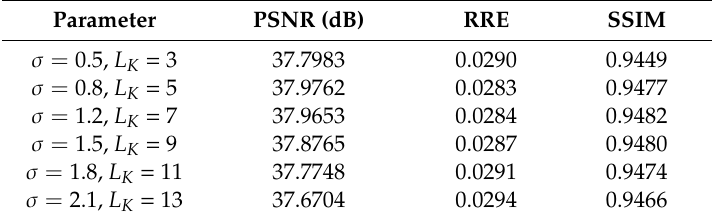
Figure 8. Thorax images reconstructed by the SIR-STV 1 method with respect to different 𝜎 and 𝐿 𝐾 . The display window is [–1000, 667] HU. Table 3. A summary of the evaluation indexes of the reconstructed image in Figure 8.